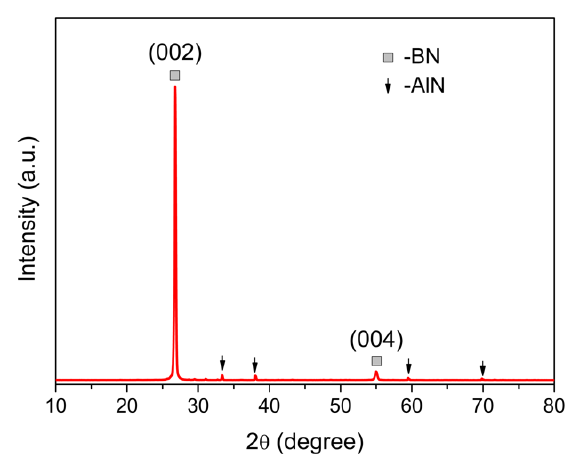
Figure 2. XRD patterns of the obtained BN nanotubes.